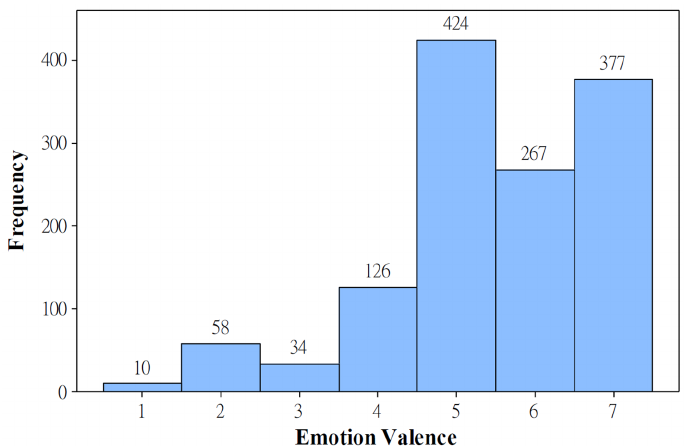
Figure 3. The distribution of data collection against the emotional valence of all 16 participants.